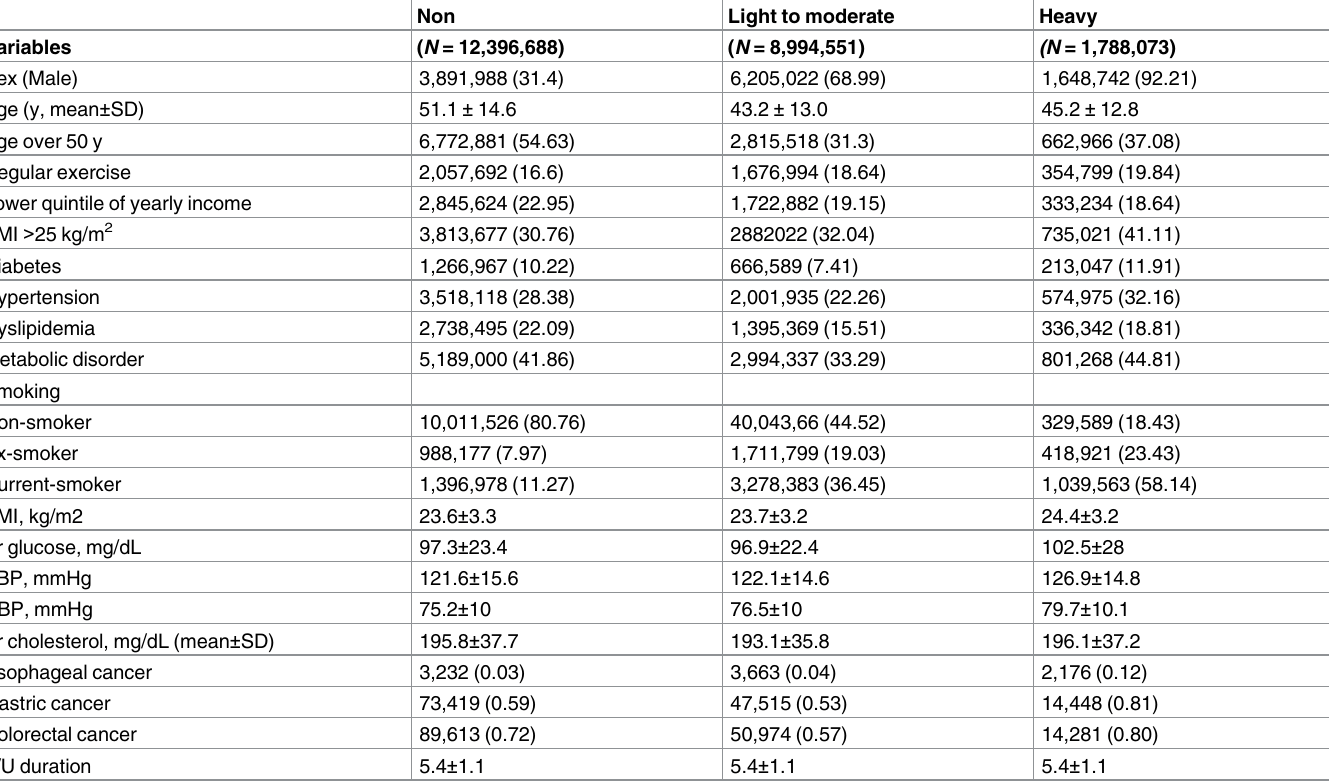
Table 1. Demographics of the alcohol drinkers and nondrinkers in the NHIC cohort (2009–2012). Non Light to moderate